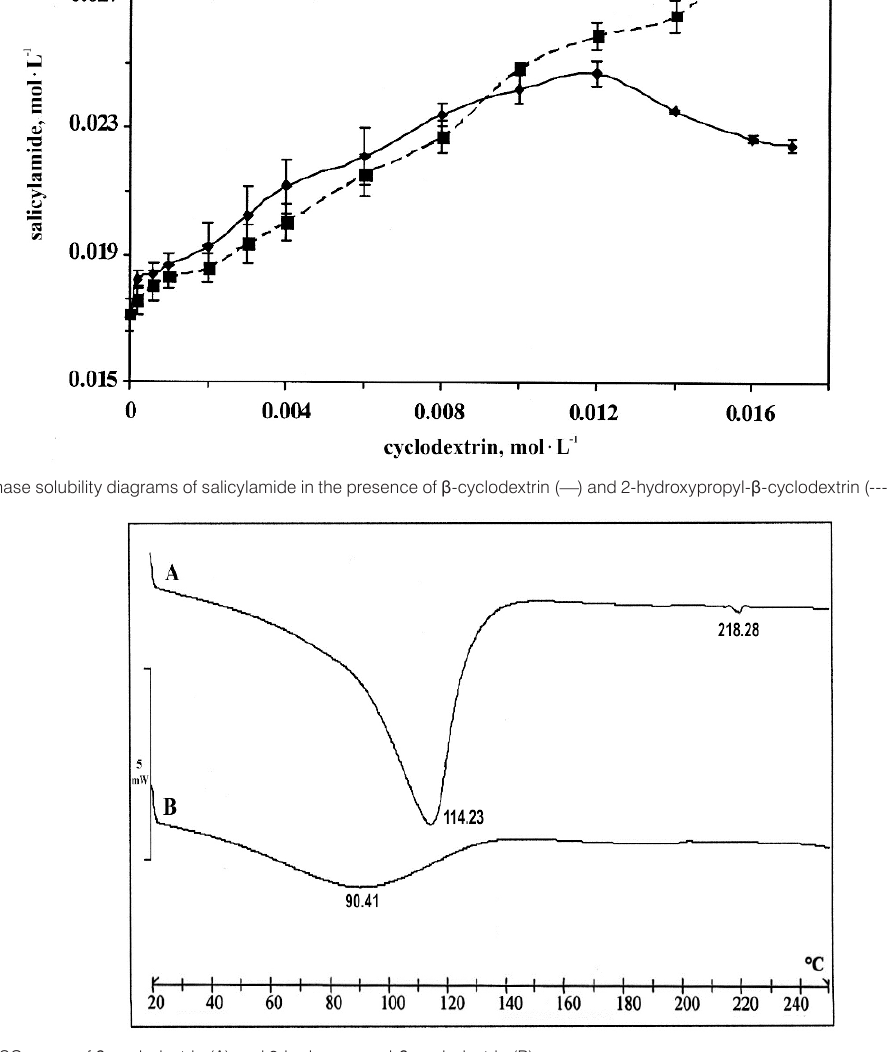
Figure 2. DSC scans of β -cyclodextrin (A) and 2-hydroxypropyl- β -cyclodextrin